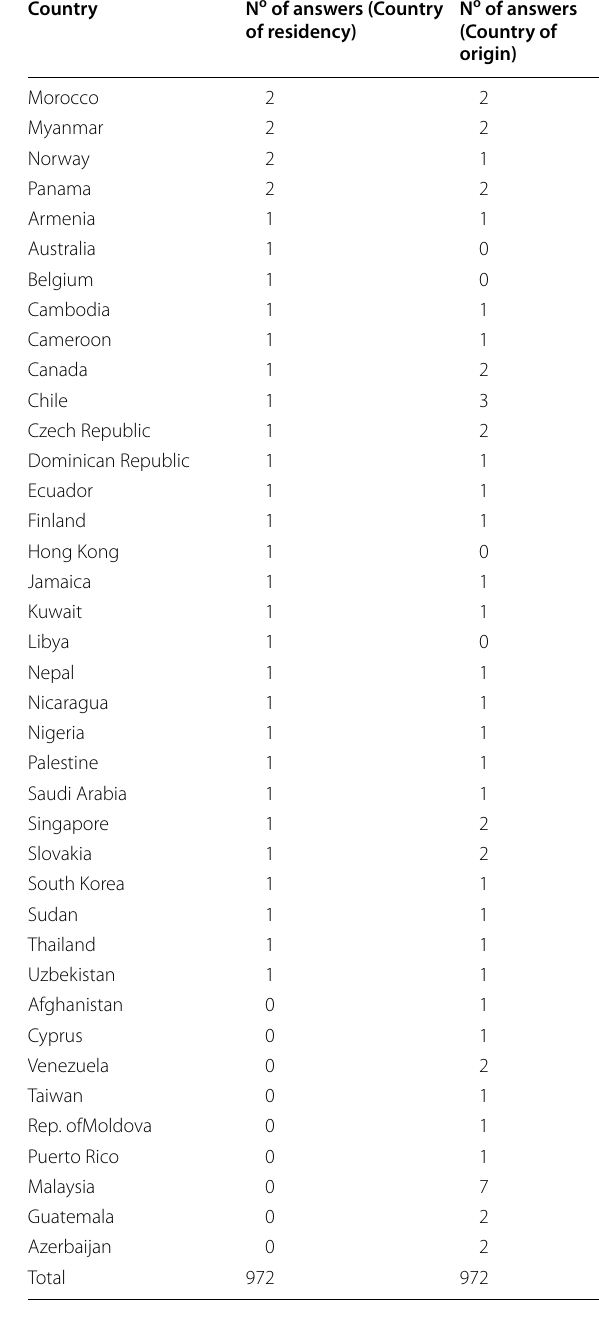
Table 2 The absolute number of completed answers stratified by country of origin and